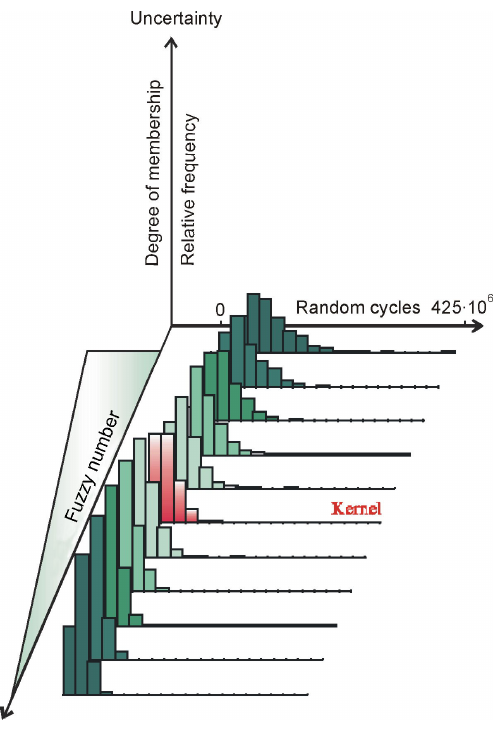
Fig. 9. Fuzzy set of fatigue resistance